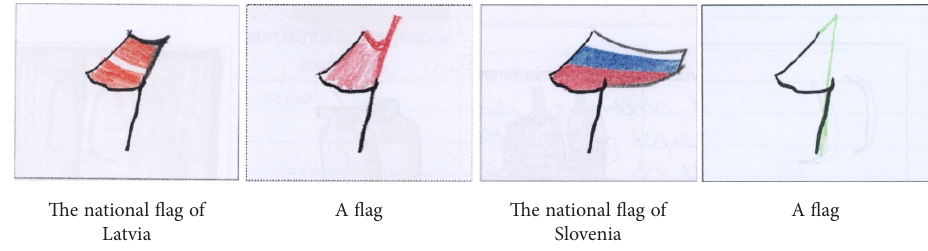
Figure 22. The creative task: interpretation of Fragment 3 – flags (source: testingmom.com,